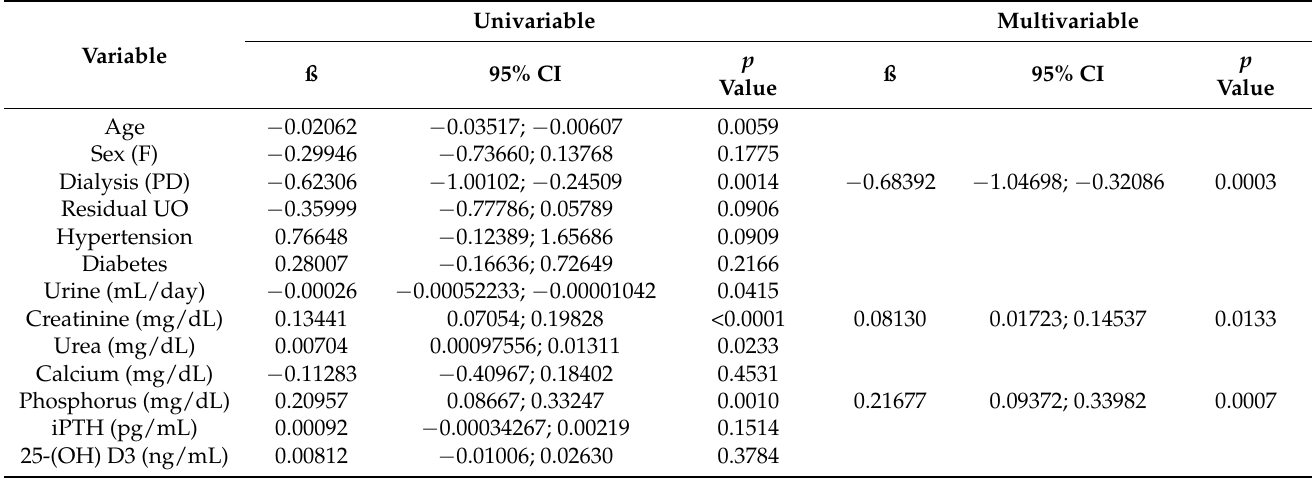
Figure 4. cFGF23 level distribution by residual urine output (UO) volume . Table 3. Univariable and multivariable regression analysis of the factors associated with cFGF23 levels (RU/mL); abbreviations: ß, the regression coefficient of the univariable or multivariable linear regression; CI, confidence